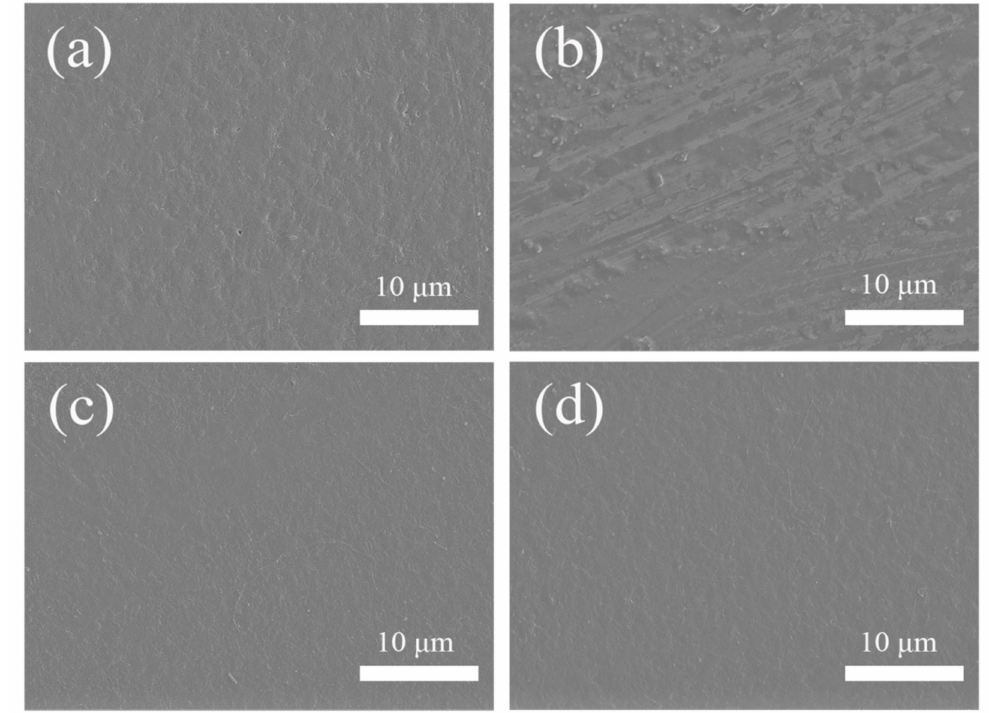
Figure 9. SEM images of the composites before and after corrosion treatment: ( a , b ) COC/20 vol % Sr 2 CeO 4 ; ( c , d ) COC/20 vol % Sr 2 CeO 4 @SiO 2